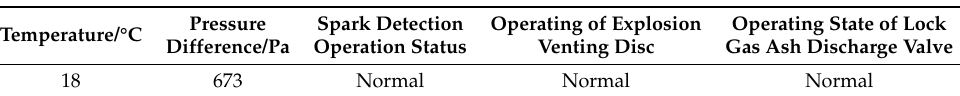
Table 15. Example experimental